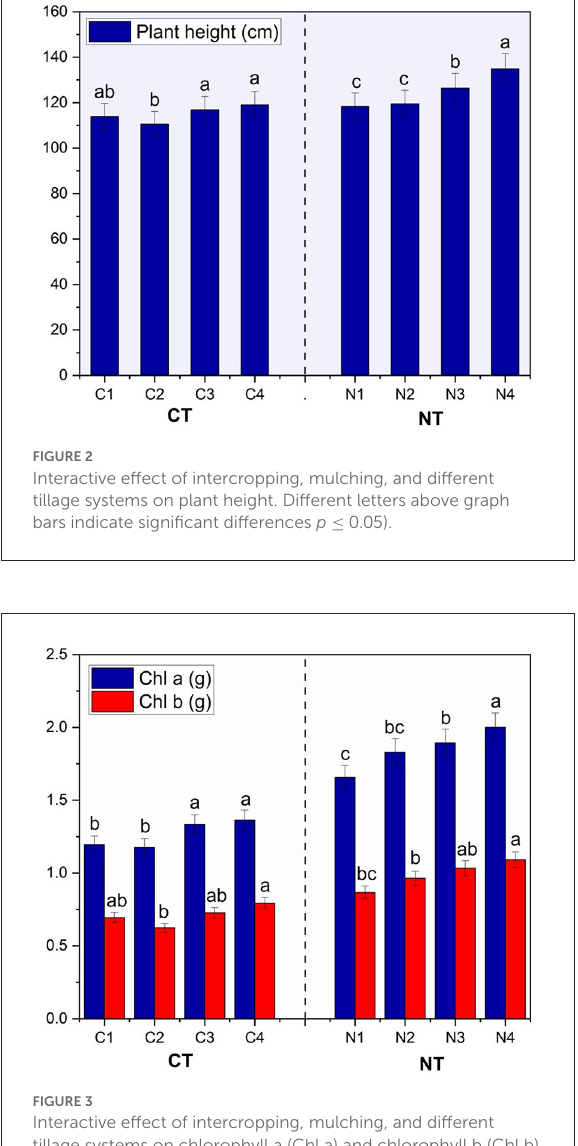
FIGURE3 Interactive effect of intercropping, mulching, and different tillage systems on chlorophyll a (Chl a) and chlorophyll b (Chl b) contents. Other letters above graph bars indicate significant differences at p ≤ 0.05).